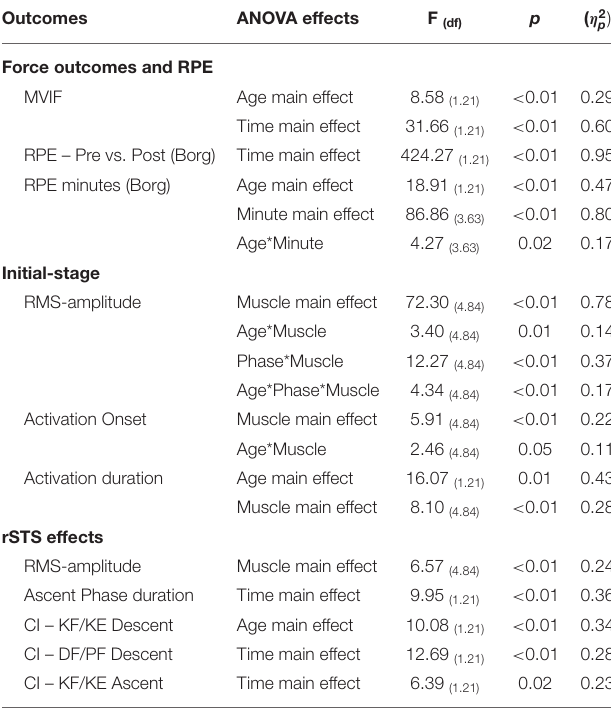
TABLE 1 | Participants’ characteristics and scores on questionnaires. Older